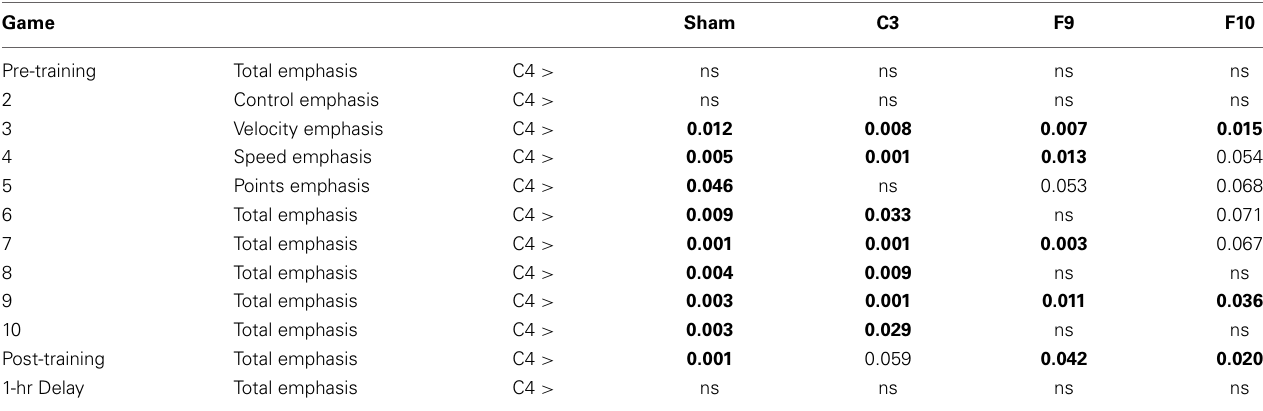
Table 3 | Velocity subscore simple effects comparing group at each